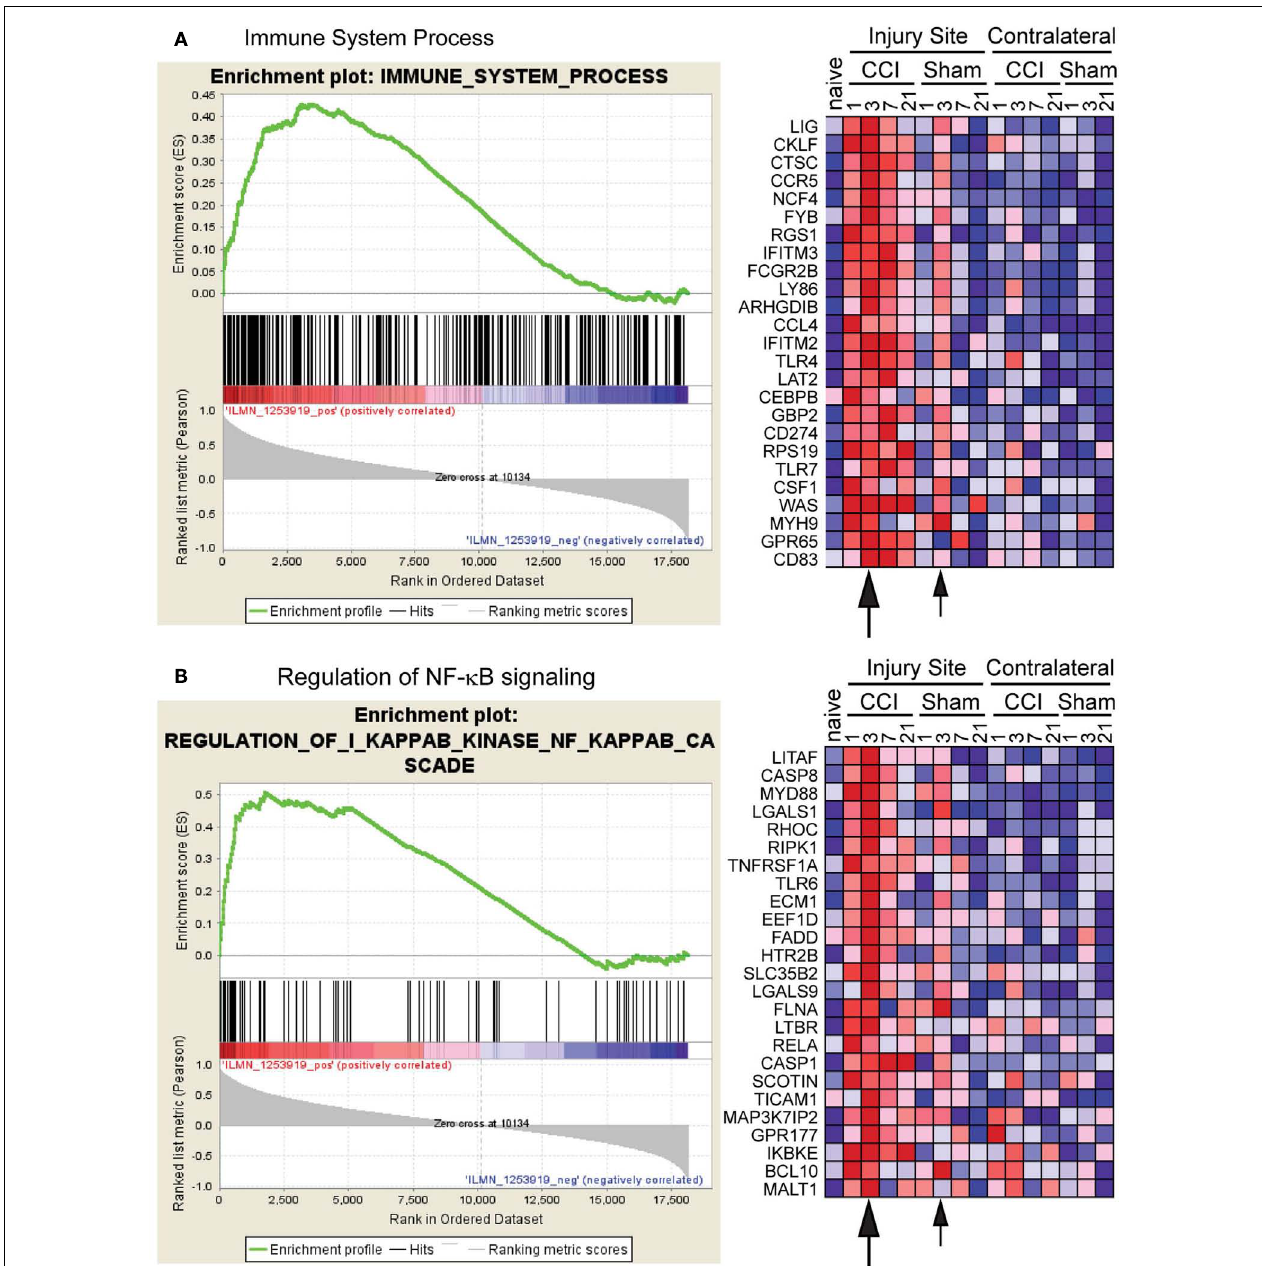
genes in the set that are positively and negatively correlated with the CCL3 phenotype.The plot on the right shows the relative gene expression (red = high, blue = low) for each gene for the indicated samples. Note that the overall kinetic profiles are similar for the CCI and craniotomy (Cran) samples, with a prominent gene expression peak at day + 3 (large and small arrows indicate the day + 3 peak for CCI and craniotomy, respectively). However, the craniotomy samples generally show a lower intensity of gene expression, particularly at day + 21.